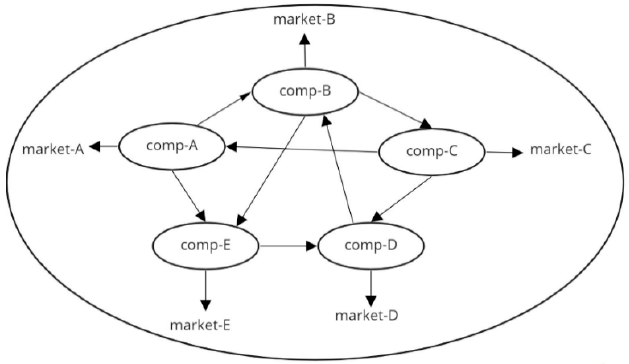
Figure 11. Collaborative network for OI ecosystem.